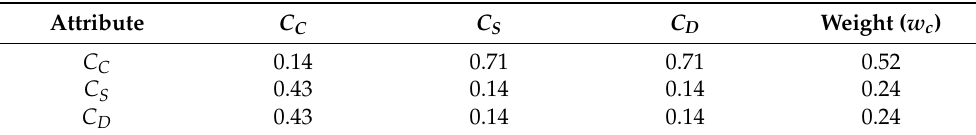
Table 9. Normalized